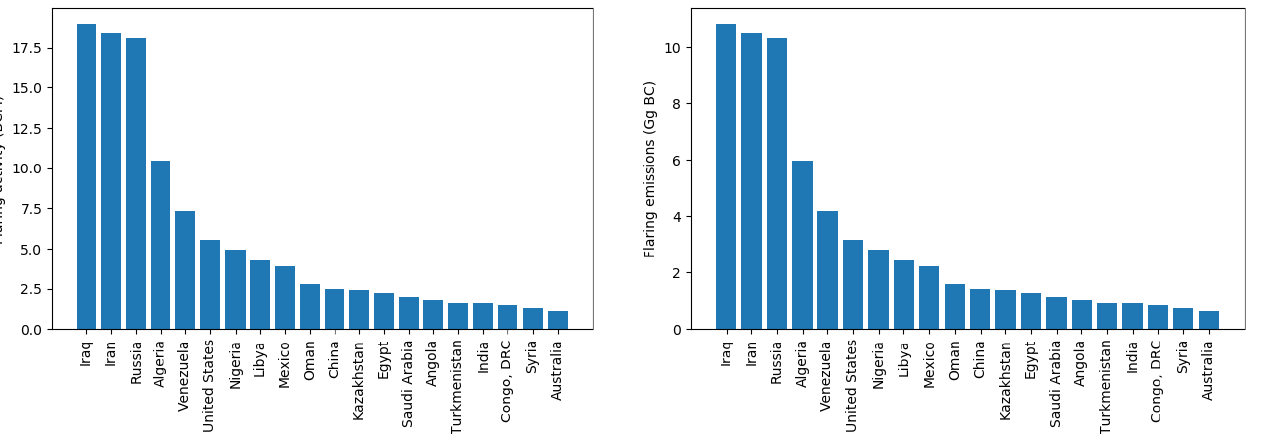
Figure 13. Flaring activity (best estimate, BCMyr − 1 ) by country (top 20).